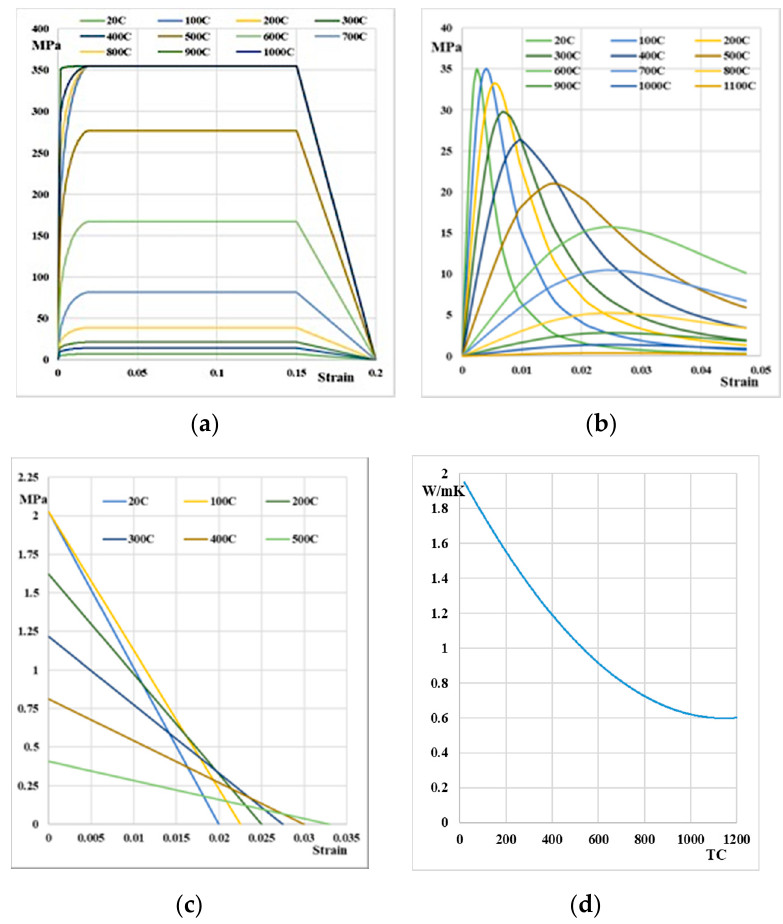
Figure 4. Temperature-dependent properties, ( a ) Stress-strain curve of structural steel, ( b ) compres- sive behaviour concrete, ( c ) Tensile Behaviour Concrete, ( d ) Thermal conductivity of concrete. A uniformly distributed load representing the test loads was applied during FEM.